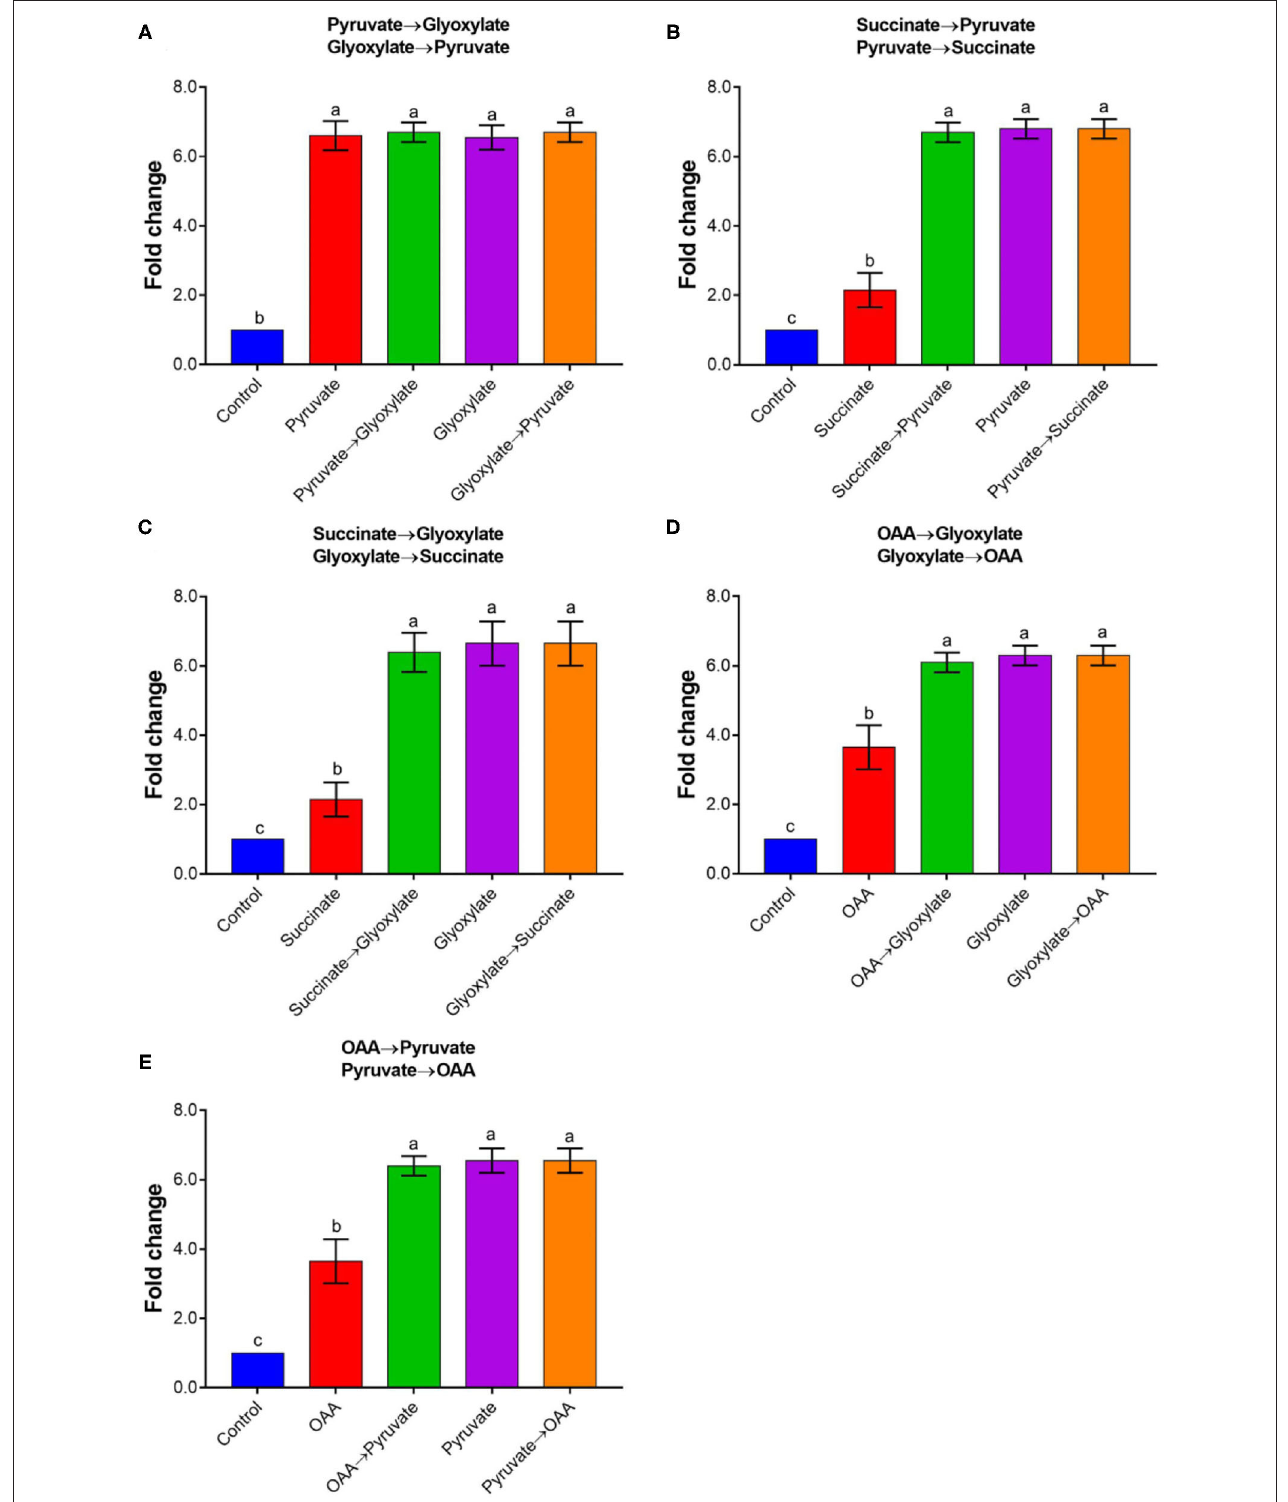
FIGURE 6 | The combined activation of rAtAOX1A by different organic acids. Changes in rAtAOX1A oxygen consumption rate after successive treatments with pyruvate/glyoxylate (A) , pyruvate/succinate (B) , succinate/glyoxylate (C) , OAA/glyoxylate (D) , and OAA/pyruvate (E) . Within this experiment, the membrane-bound AtAOX1A protein was used for the activation test. For the substrate, 1mM NADH was used as and 1mM KCN was added to avoid the leaking respiration pass through complex IV. Basal activities (no effector, control) were ∼ 8 µ mol O 2 min − 1 mg − 1 protein for rAtAOX1A, and 10mM of effectors were used in this experiment. Data are mean values ± SD for five independent experiments. Different letters mark statistically significant differences ( p < 0.05).